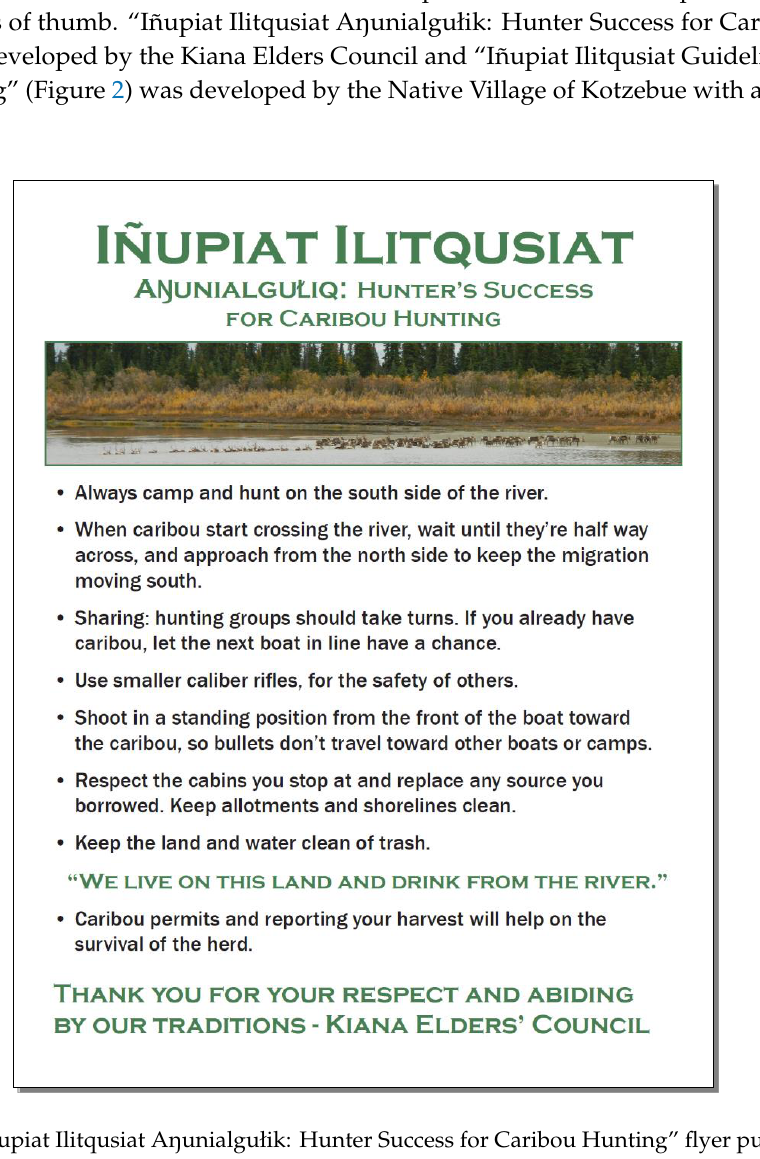
Figure 1. “Iñupiat Ilitqusiat A ŋ unialgułik: Hunter Success for Caribou Hunting” flyer published by Kiana Elders Council first in 2015 and updated in 2017.